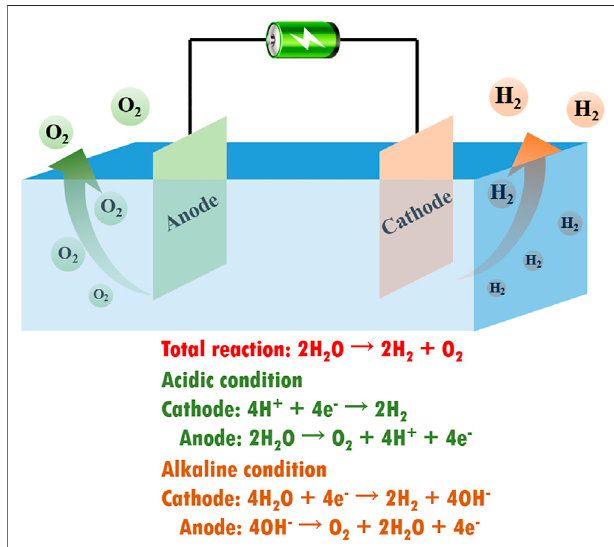
FIGURE 1 | Schematic illustration of an electrolyzer for electrochemical water splitting and corresponding reaction equations in different reaction